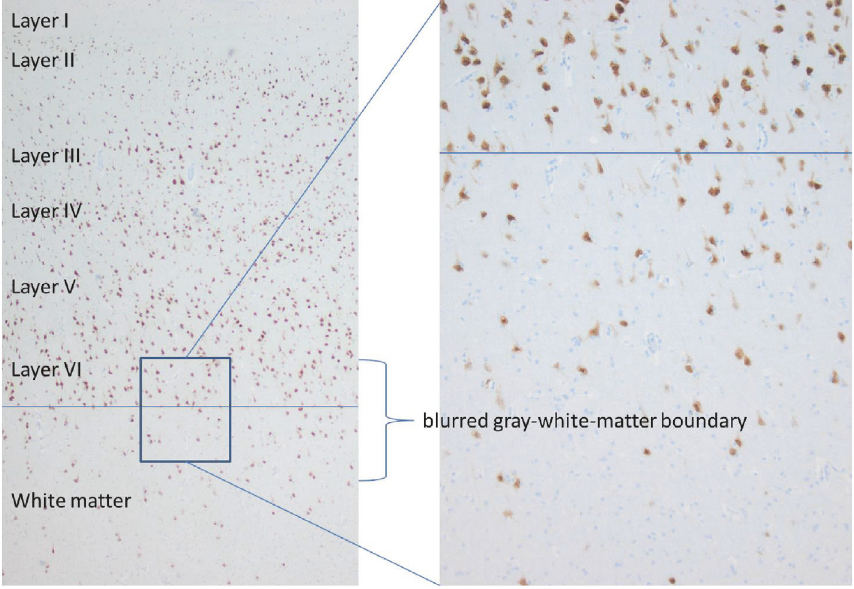
Figure 3: NeuN immunohistochemistry (neurons are labeled).